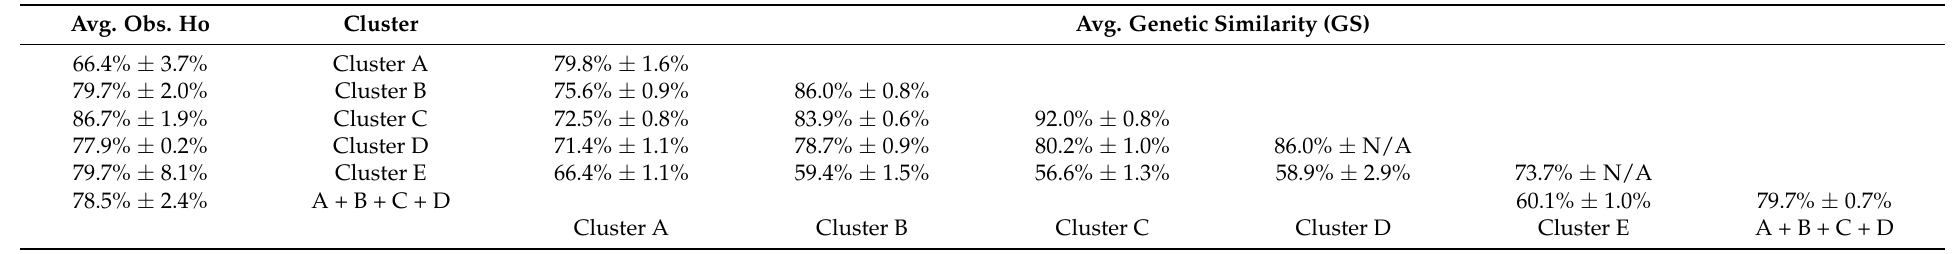
Table 3. Average genetic similarity of clusters identified through the construction of the UPGMA dendrogram, and average observed homozygosity (Avg. Obs. Ho). Avg. Obs. Ho Cluster Avg. Genetic Similarity (GS) 66.4% ±